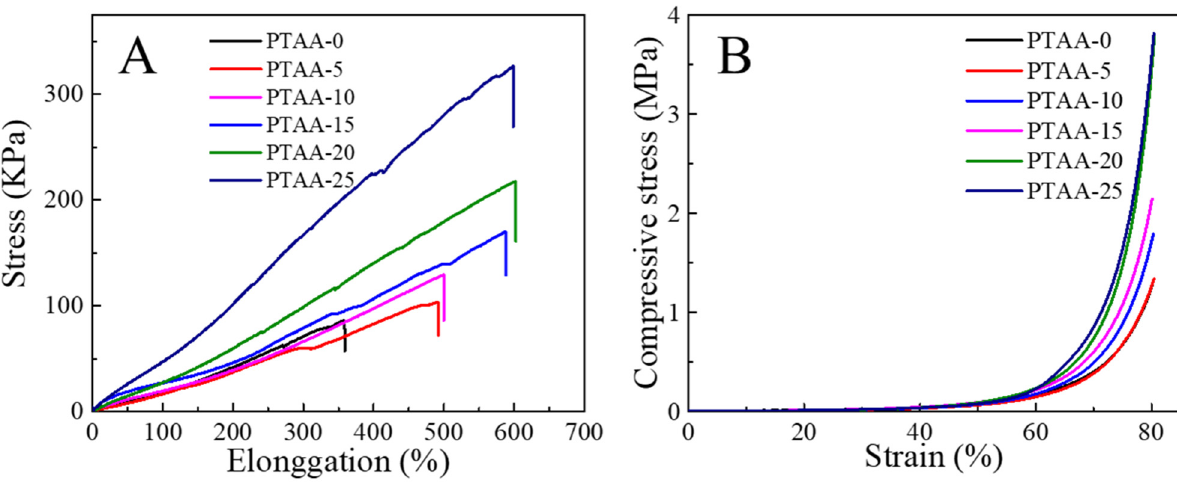
Figure 6. ( A ) The tensile strain–stress curves and ( B ) the compressive strain–stress curves of various